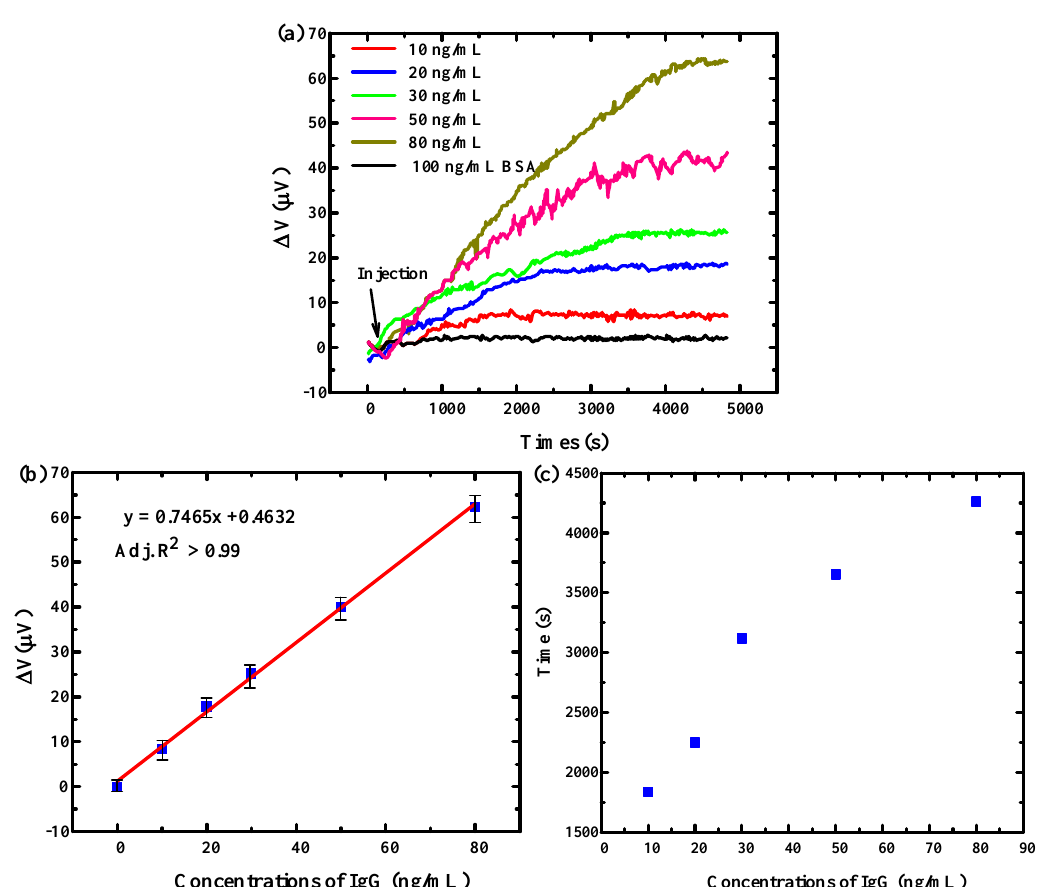
Figure 8. ( a ): The response output curve of PI/Ti/SiO 2 flexible microcantilever microcantilever to IgG Figure 8. ( a ) The response output curve of PI / Ti / SiO 2 flexible microcantilever microcantilever to IgG detection ( b ): The linear relationship between the microcantilever response voltage and IgG detection( b )ThelinearrelationshipbetweenthemicrocantileverresponsevoltageandIgGconcentration. concentration. ( c ): The relationship between the microcantilever response time and the IgG ( c ) The relationship between the microcantilever response time and the IgG concentration.